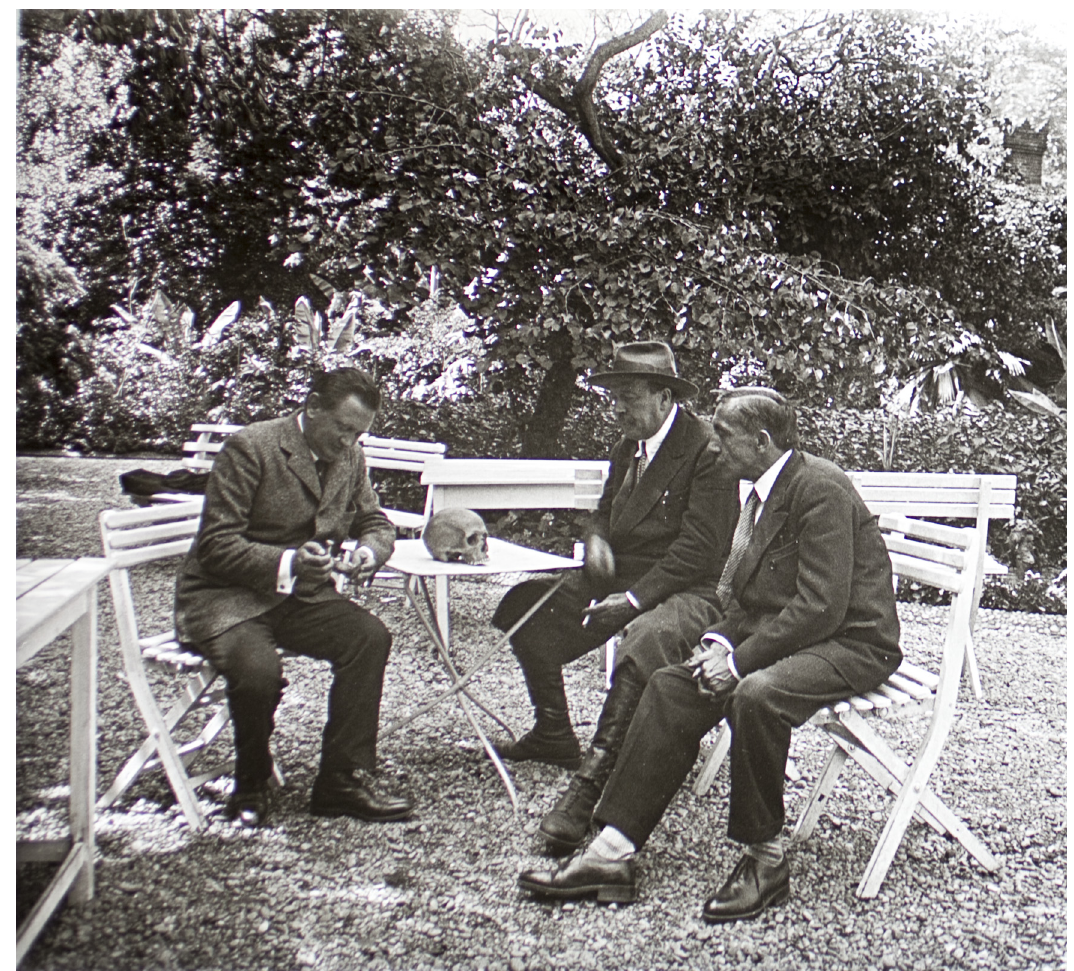
Figure 3: Garden at Count Vega del Sella ’ s palace in Nueva de Llanes ( Asturias ) in about 1925 – 1930. Left: Hugo Obermaier; above right: Vega del Sella; below right: unknown person. Photo: Instituto de Patrimonio Cultural de España. Ministerio de Cultura y